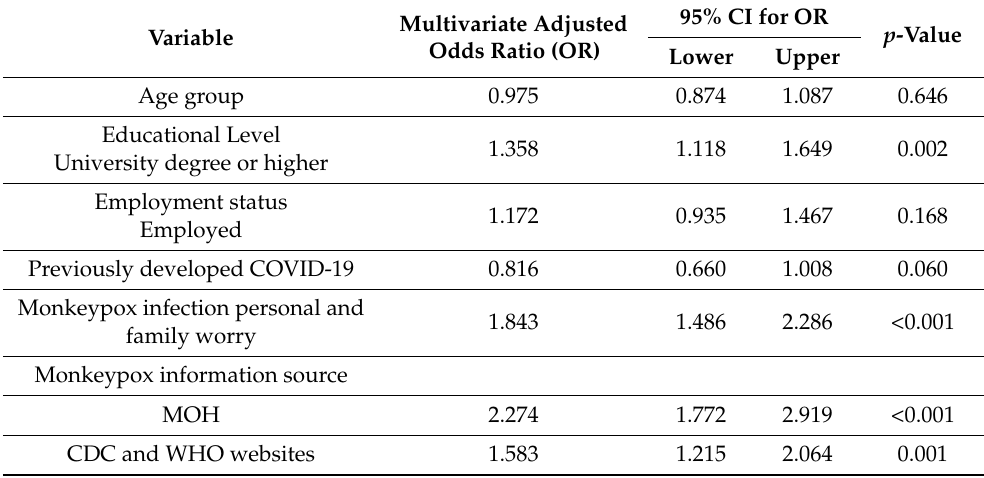
Table 1. Multivariate binary logistic regression analysis of the general public’s odds of high MPOX knowledge score. (KSA, 27 May to 5 June